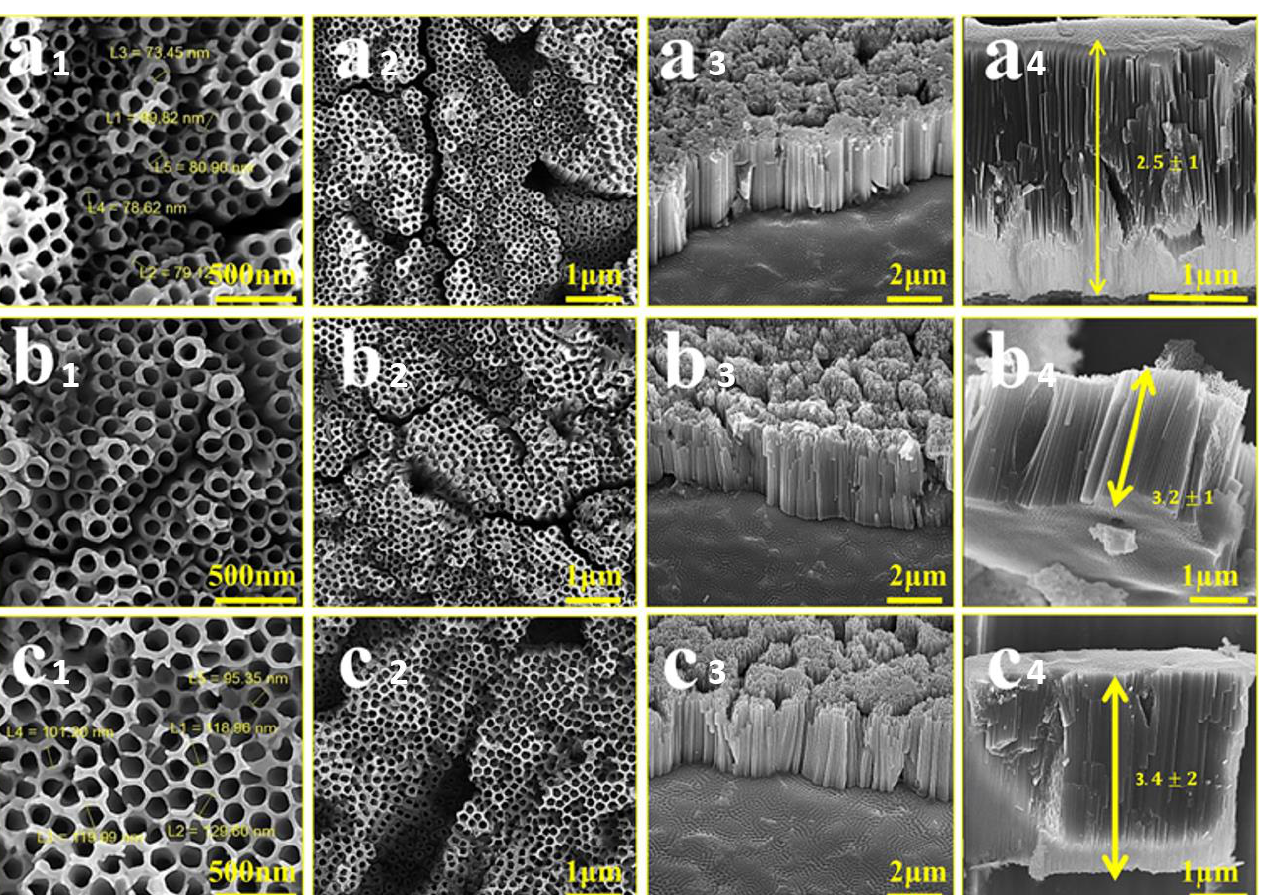
Figure 1. Morphology of Ti 6 – 4 surface after anodizing process under voltage of ( a ) 50, ( b ) 60, and ( c ) 75 V. Reproduced from [25] with permission from Elsevier™.